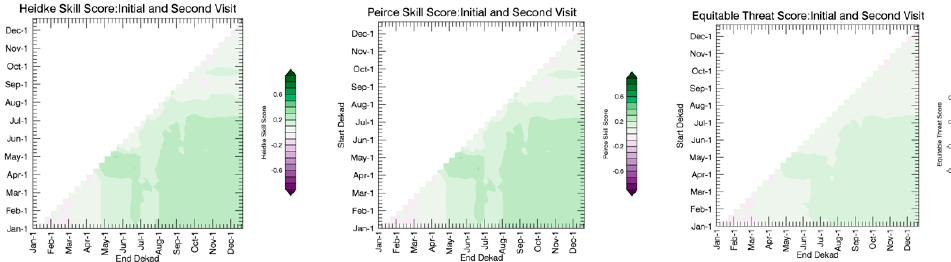
Figure 7. Heidke skill score, Pierce skill score, and equitable threat score for a variety of ARC2 rainfall accumulation intervals over the year. Higher skill scores reflect that the accumulation interval aligns better with farmer-identified payout years. The start and end dekads (on the y- and x-axis, respectively) indicate the 10-day period during the calendar that the accumulation calculation starts or ends. The lower-right portion of the graphic captures accumulation over the full calendar year, moving up from the lower right indicates a later start of accumulation, while moving to the left on the graphic represents an earlier end to the accumulation interval. Farmer-reported "bad years" in combined visit (1st and 2nd visit) to 21 villages in Tigray, Ethiopia, served as the truth data.